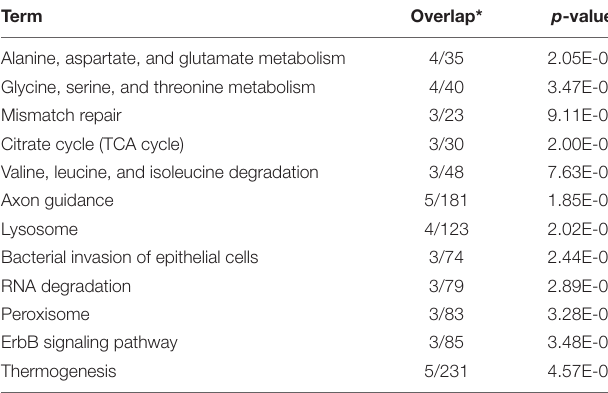
TABLE 4 | KEGG enrichment analysis of outlier